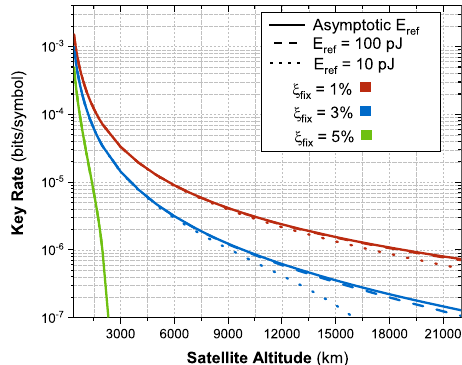
Fig. 10 Impact of the reference pulse energy on key rate. Comparison of secret key rate for different values of the reference symbol energy E ref , for the three different excess noise values considered along the